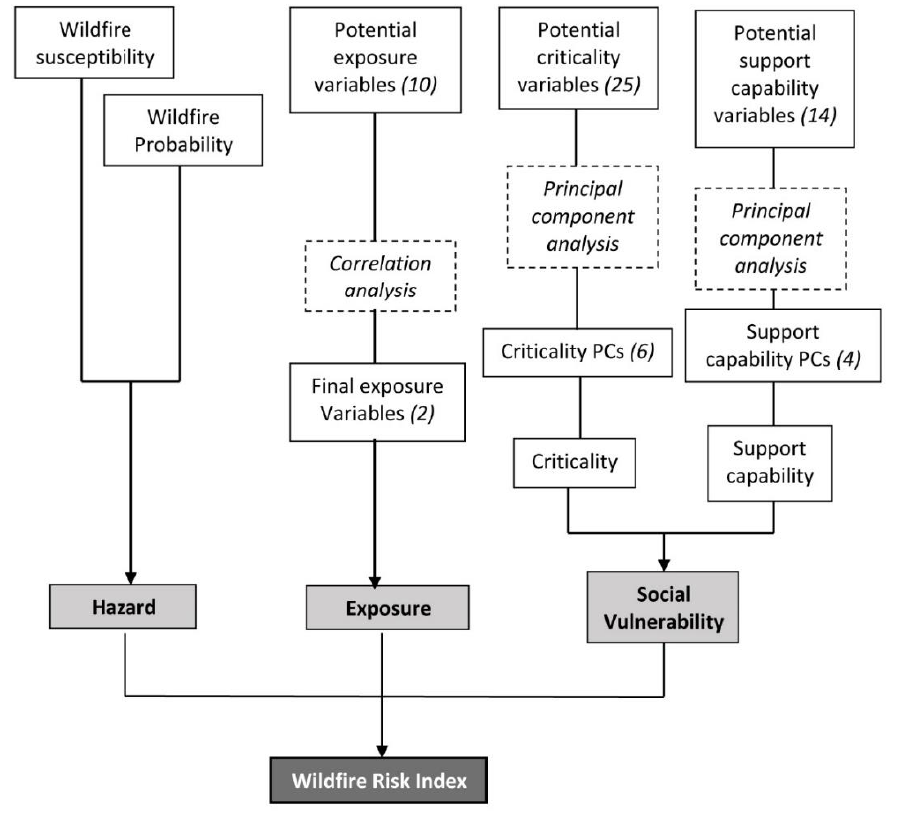
Figure 3. A schematic representation of the methodology employed to calculate the wildfire risk index. A 25 m pixel was adopted for all spatial data. ArcGIS 10.7.1. software (ESRI Inc., Redlands, CA, USA) was used for all spatial analysis